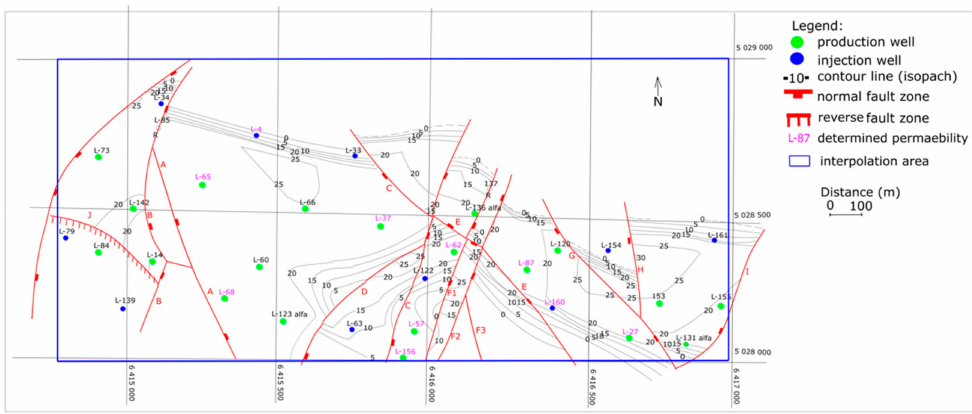
Figure 3. Thickness (isopach) map of the reservoir “L”, with borders of interpolated area, fault zone and (injection and production) wells.